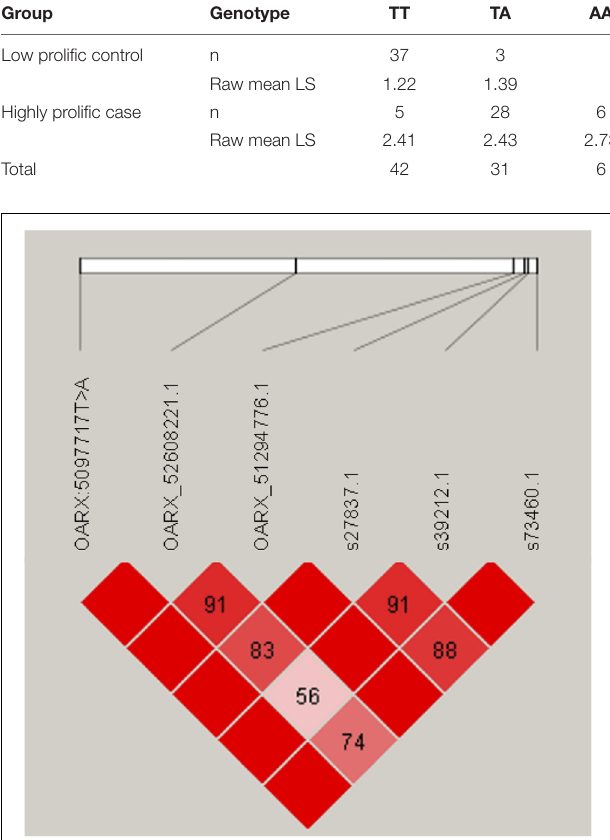
TABLE 2 | Distribution of OARX:50977717T > A SNP genotypes and associated LS in case and control groups. Group